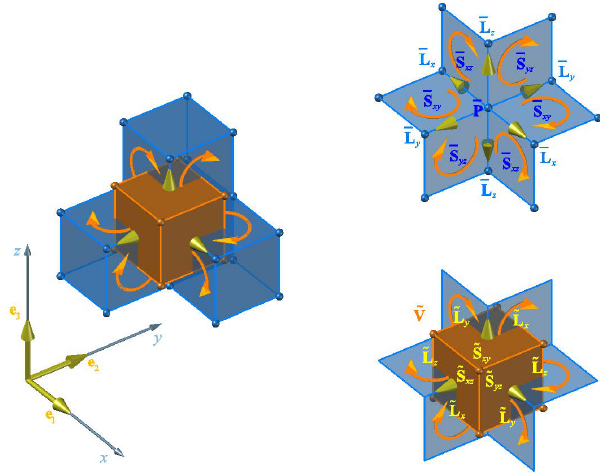
Figure 2: Relation of duality in three-dimensional space, between inner orientations of the primal cells and outer orientations of the dual